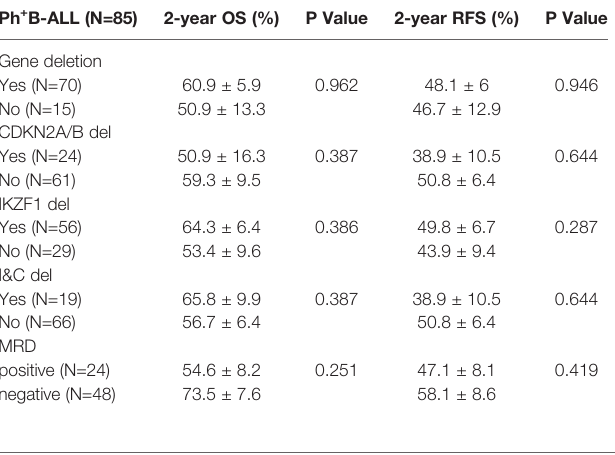
TABLE 3 | Univariate prognosis analysis of different gene deletions in Ph + B-ALL. Ph + B-ALL (N=85)